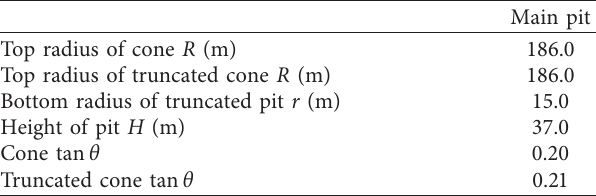
Figure 8: Geometric models: (a) cone; (b) truncated cone. Table 6: Geometric dimension of karst pit